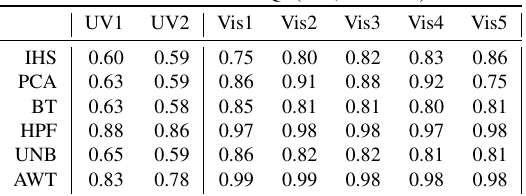
Table 7: Ina D: UIQI